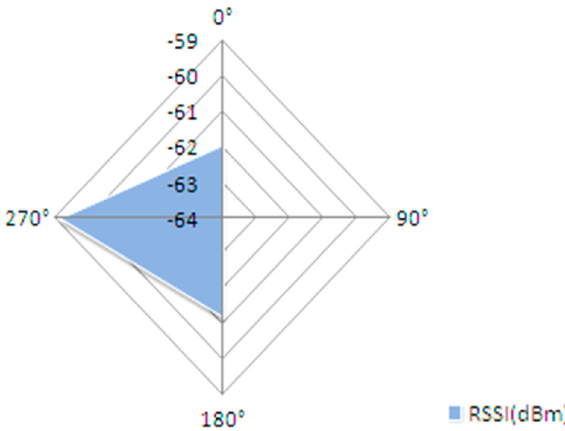
Figure 21. RSSI level vs. node orientation in a back-to-back measurement setup.